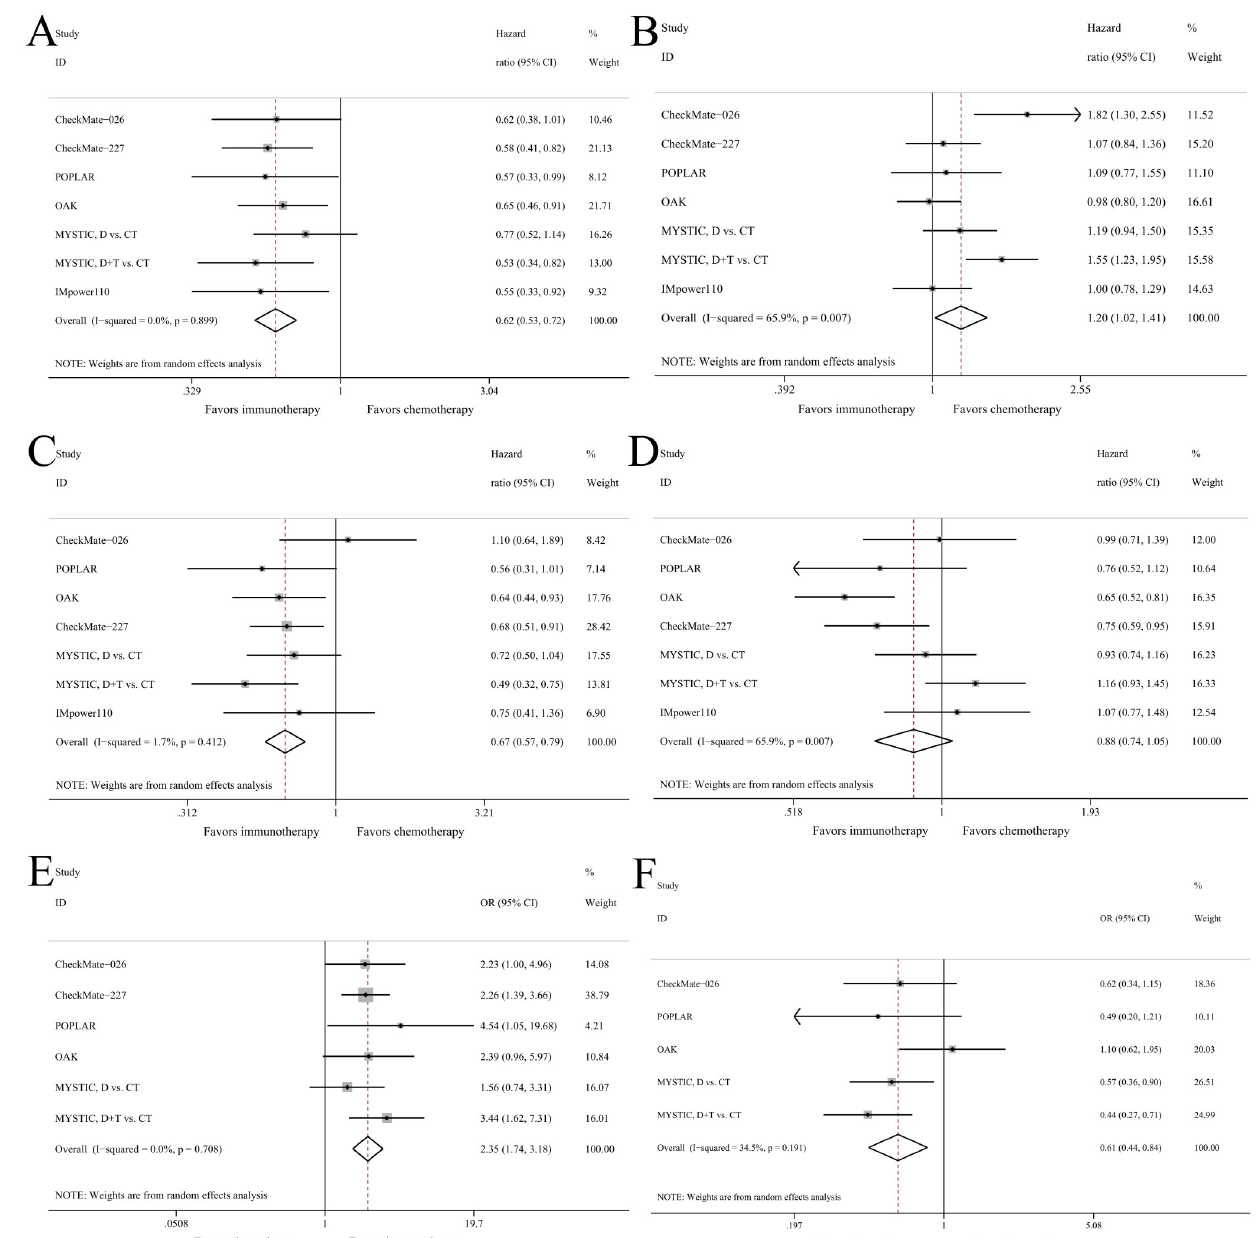
Fig 5. Forest plots of meta-analysis of immunotherapy versus chemotherapy in NSCLC patients with high or low TMB. (A) PFS in high-TMB patients; (B) PFS in low-TMB patients; (C) OS in high-TMB patients; (D) OS in low-TMB patients; (E) ORR in high-TMB patients; (F) ORR in low-TMB patients.